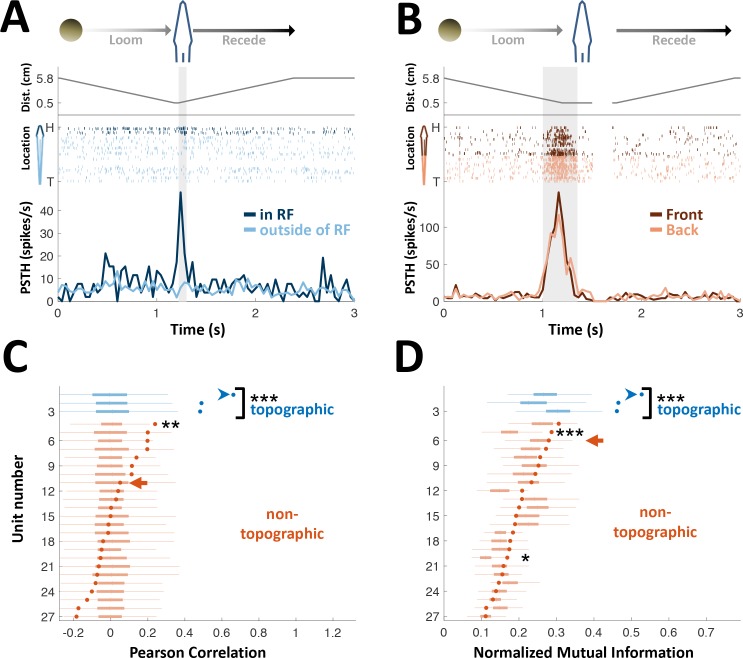
PG cells lack egocentric spatial information.(A) Example of an ‘atypical’ topographic PG cell with a restricted receptive field (RF) at the head. Looming-receding motions were performed at different locations. Top: object distance from skin vs. time; middle: spike raster plot, arranged according to object location (H = head, T = tail); bottom: PSTH within the RF (dark blue) and outside of it (light blue). (B) Example of a ‘typical’ non-topographic PG cell, responding to stimulation across the entire body. Bottom: PSTH of front (dark red) and rear (light red) halves of fish. RF extended beyond the sampled range. (C) Circles: Pearson correlation between normalized egocentric location and firing-rate for all units, in ascending order; box-plots: distribution of correlations obtained by random permutations of locations (control). Only one non-topographic cell had correlations that statistically differed significantly from those in the randomized boxes (**). (D) Circles: normalized mutual information (MI) between egocentric location and firing-rate for all units, in ascending order; box plots, distribution of MI obtained by random permutations of locations (control). Only two non-topographic cells had MI that statistically differed significantly from those in the randomized boxes (* and ***). Blue arrowheads in (C) and (D) mark the cell depicted in (A); Red arrows mark the cell depicted in (B). P values obtained using permutation test: ‘*’, p < 0.05; ‘**’, p < 0.01; ‘***’, p < 0.001.